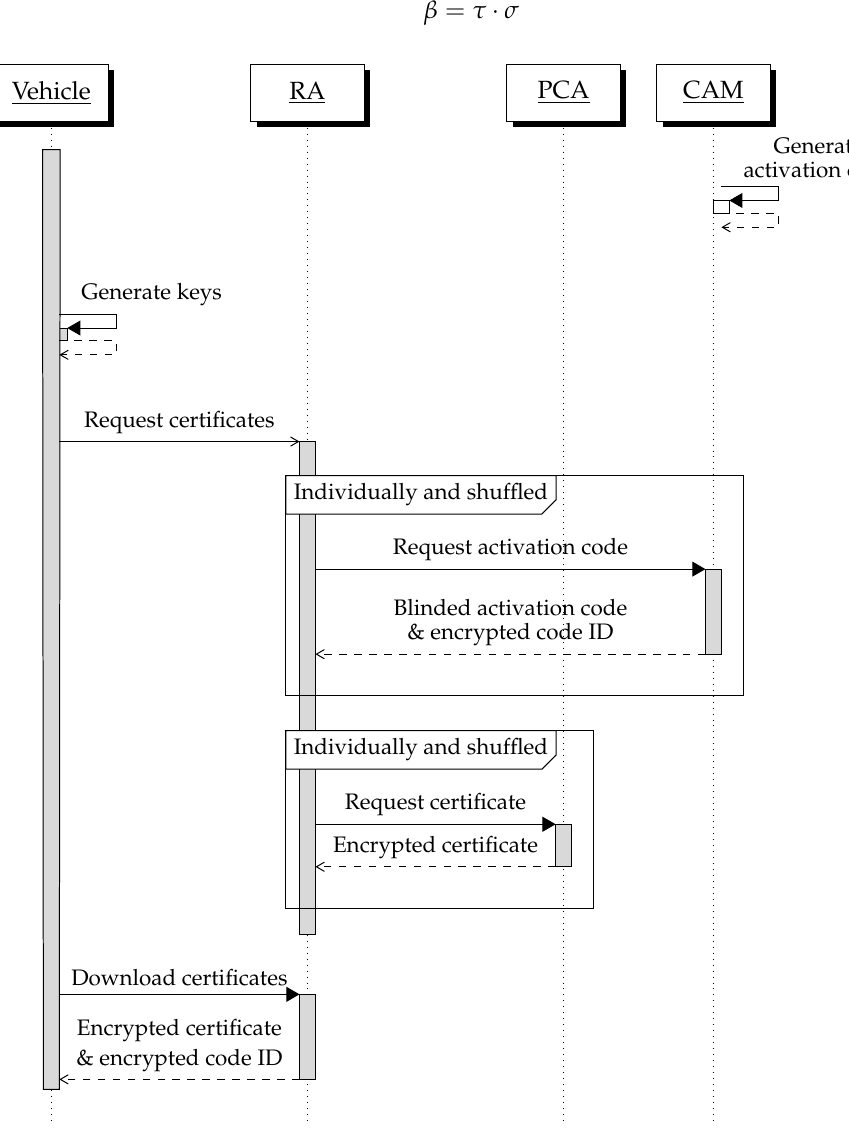
Figure 2. Pseudonym certificate issuing